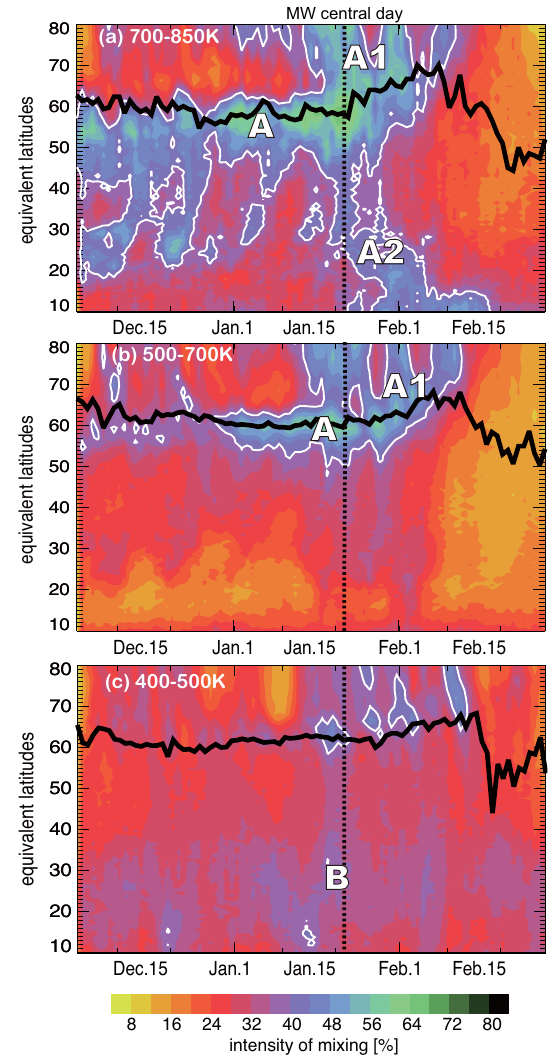
Figure 6. CLaMS zonal mean mixing intensity within three layers: (a) 700–850K, (b) 500–700K and (c) 400–500K overlaid by the location of the vortex edge (thick black lines Nash et al., 1996). The white contours indicate the mixing intensity of 40%. The letters mark the regions of high mixing intensity and correspond to the letters in Fig.